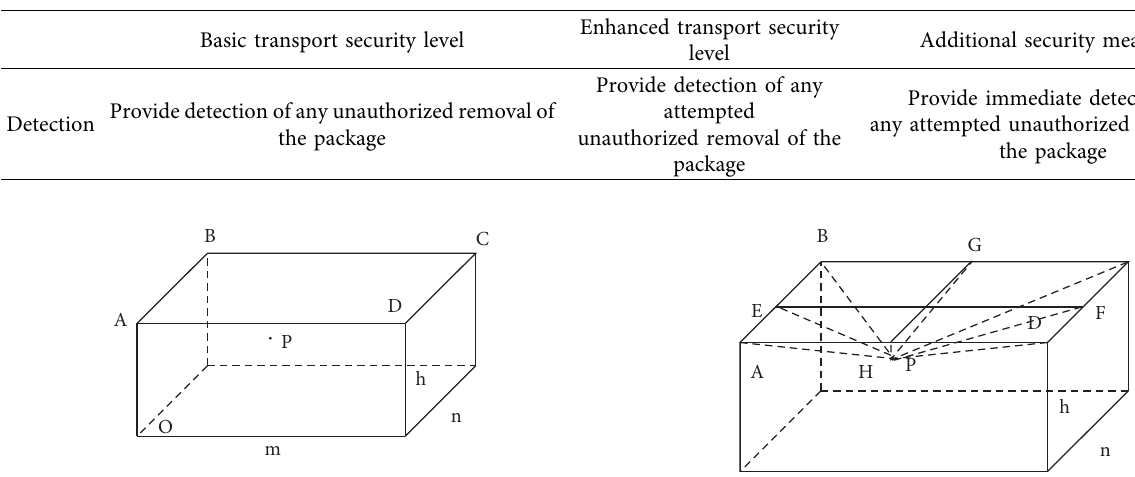
Table 1: Targets of illegal movement detection function under different transportation security levels.